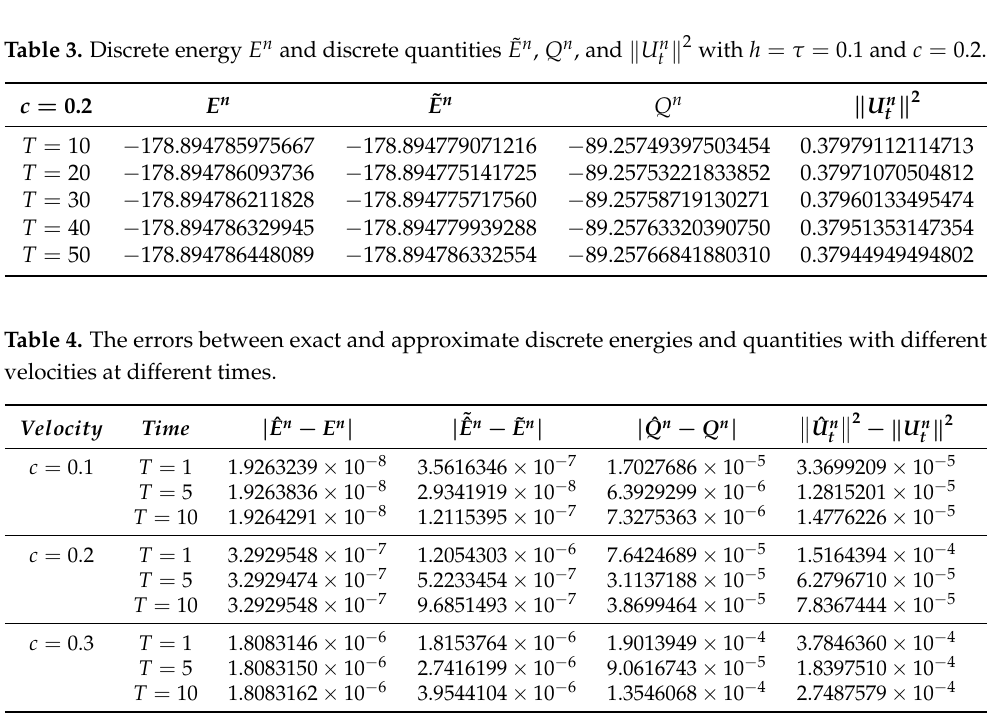
(cid:107) 2 with h = τ = 0.1 and c = 0.2. t